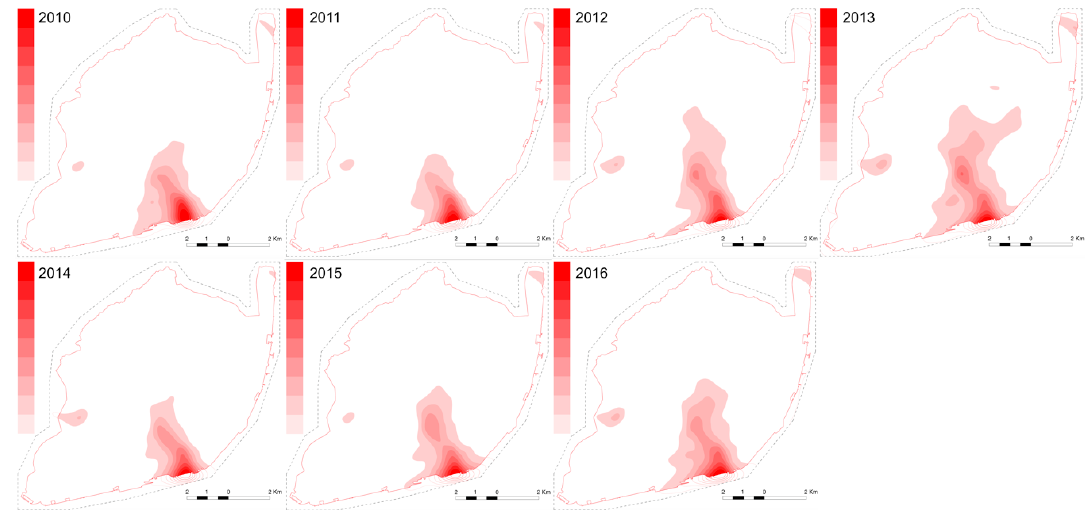
Figure 8. Yearly Dual KDE of building renovation permit requests in the 2011–2016 period in the city of Lisbon. h = 3150 m Source: Authors.